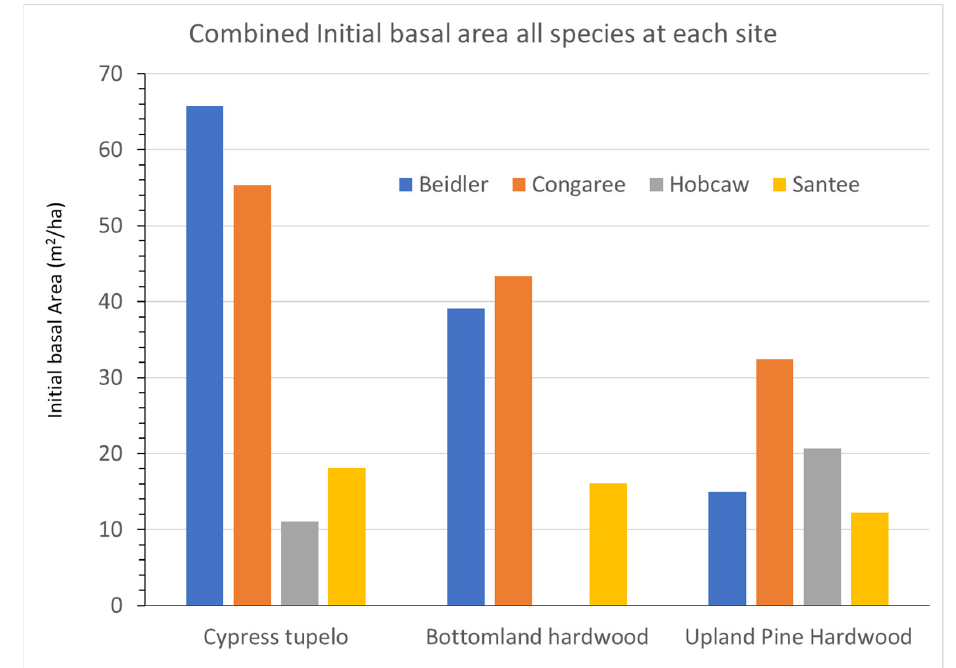
Figure 3. Initial basal areas of all species at each site for each vegetation type.